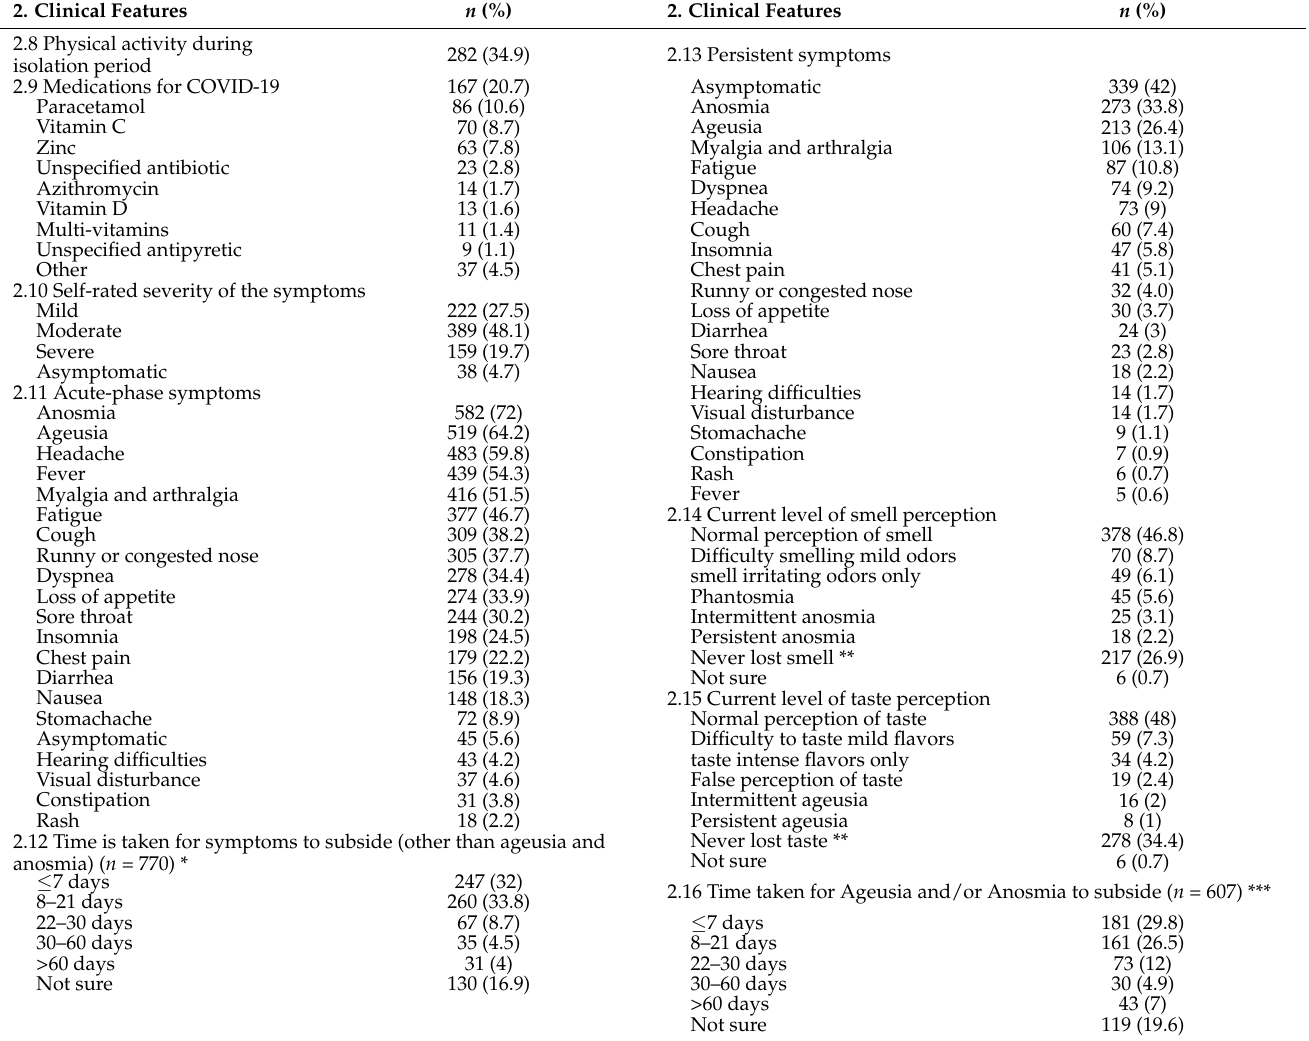
Table 2. Clinical features of COVID-19 patients during the acute phase of the